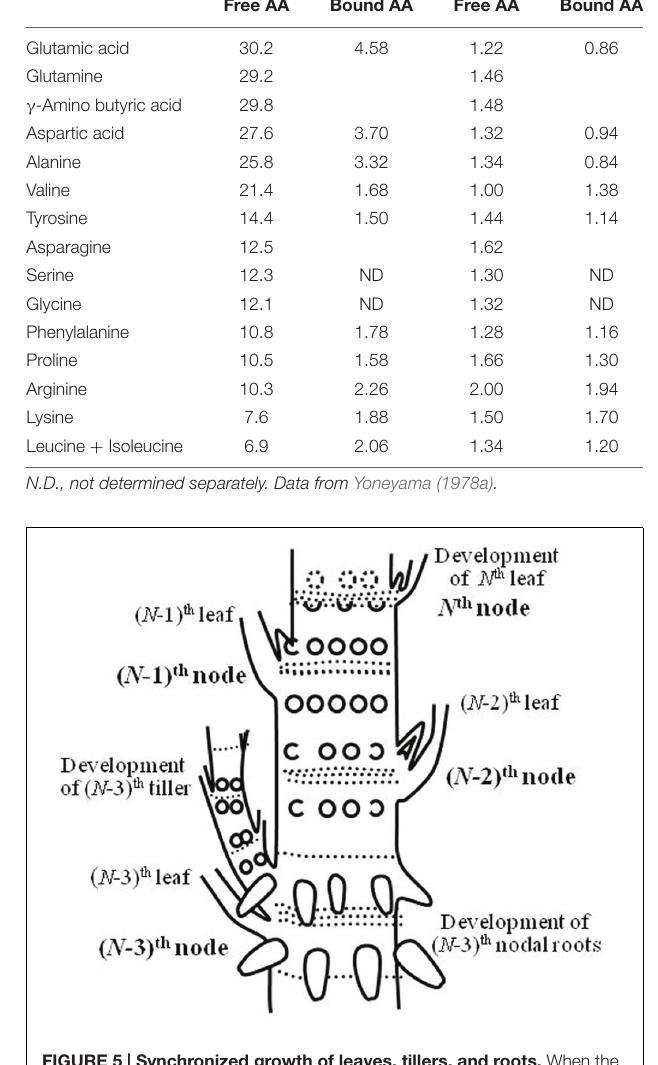
FIGURE 5 | Synchronized growth of leaves, tillers, and roots. When the N th leaf blade develops from the N th node, the tiller and roots actively develop from the ( N -3)th node. This image was drawn from the Japanese edition of Hoshikawa